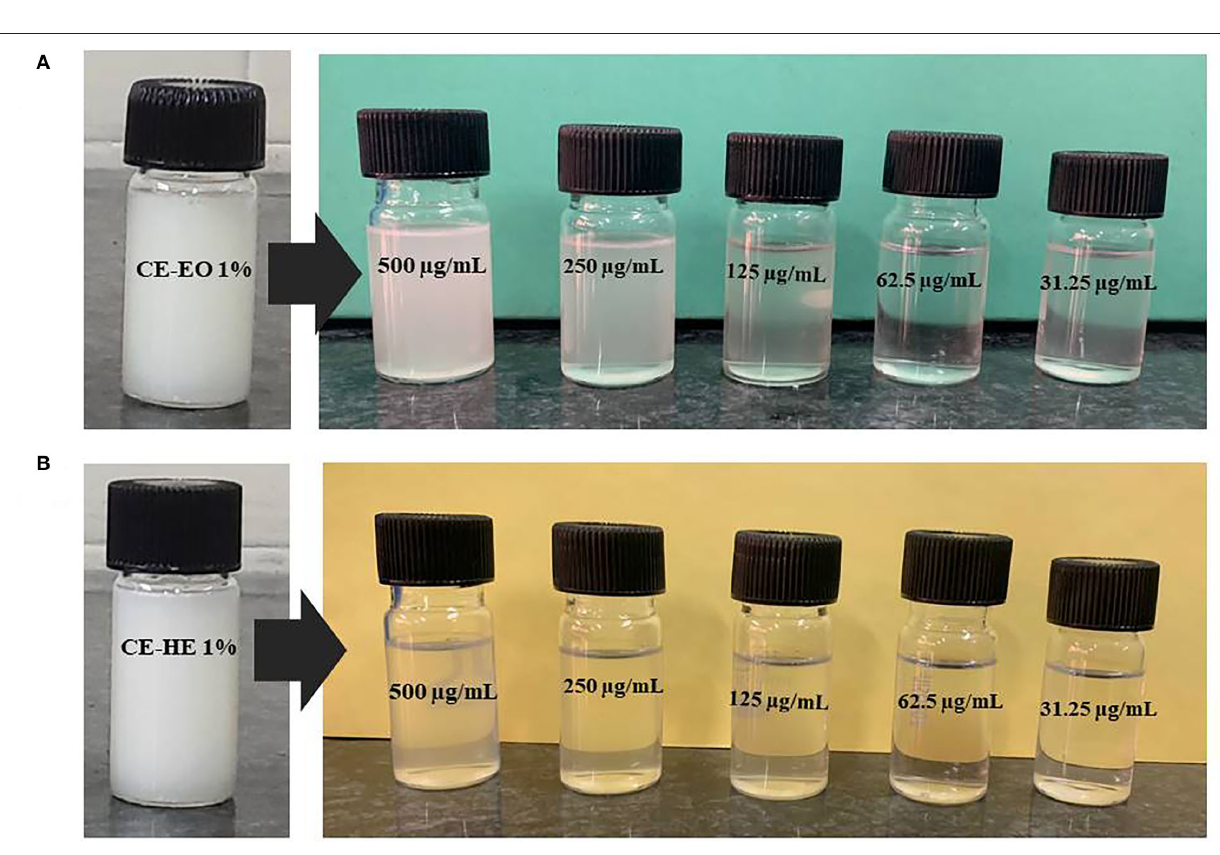
Frontiers in Plant Science |